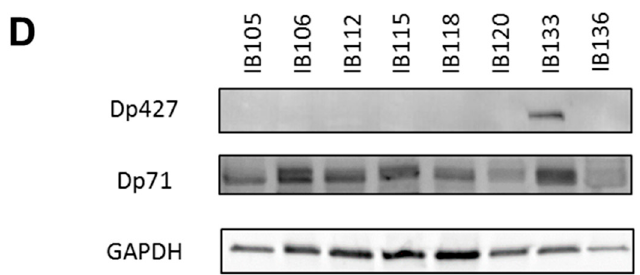
Figure 2. Expression of DMD isoforms in soft-tissue sarcoma (STS) tumors and cell lines. ( A ) Respective expression of DMD isoforms in 145 tumors determined by RNA sequencing. Red horizontal line is minimal expression threshold: 0.001 Fragments Per Kilobase Million (FPKM) ~ − 9.97 log2 FPKM. ( B ) Expression of Dp427 and Dp71 depending on tumor histotype obtained by RNA sequencing. GIST: gastrointestinal tumor; Undiff: undifferentiated sarcoma; LMS: leiomyosarcoma; DDLPS: dedifferentiated liposarcoma; pLPS: pleomorphic liposarcoma; MFS: myxofibrosarcoma; pRMS: pleomorphic rhabdomyosarcoma; UPS: undifferentiated pleomorphic sarcoma. ( C ) Respective expression of Dp427 and Dp71 in sarcoma cell lines determined by RNA sequencing. ( D ) Respective abundance of Dp427 and Dp71 in sarcoma cell lines assessed by Western blotting.